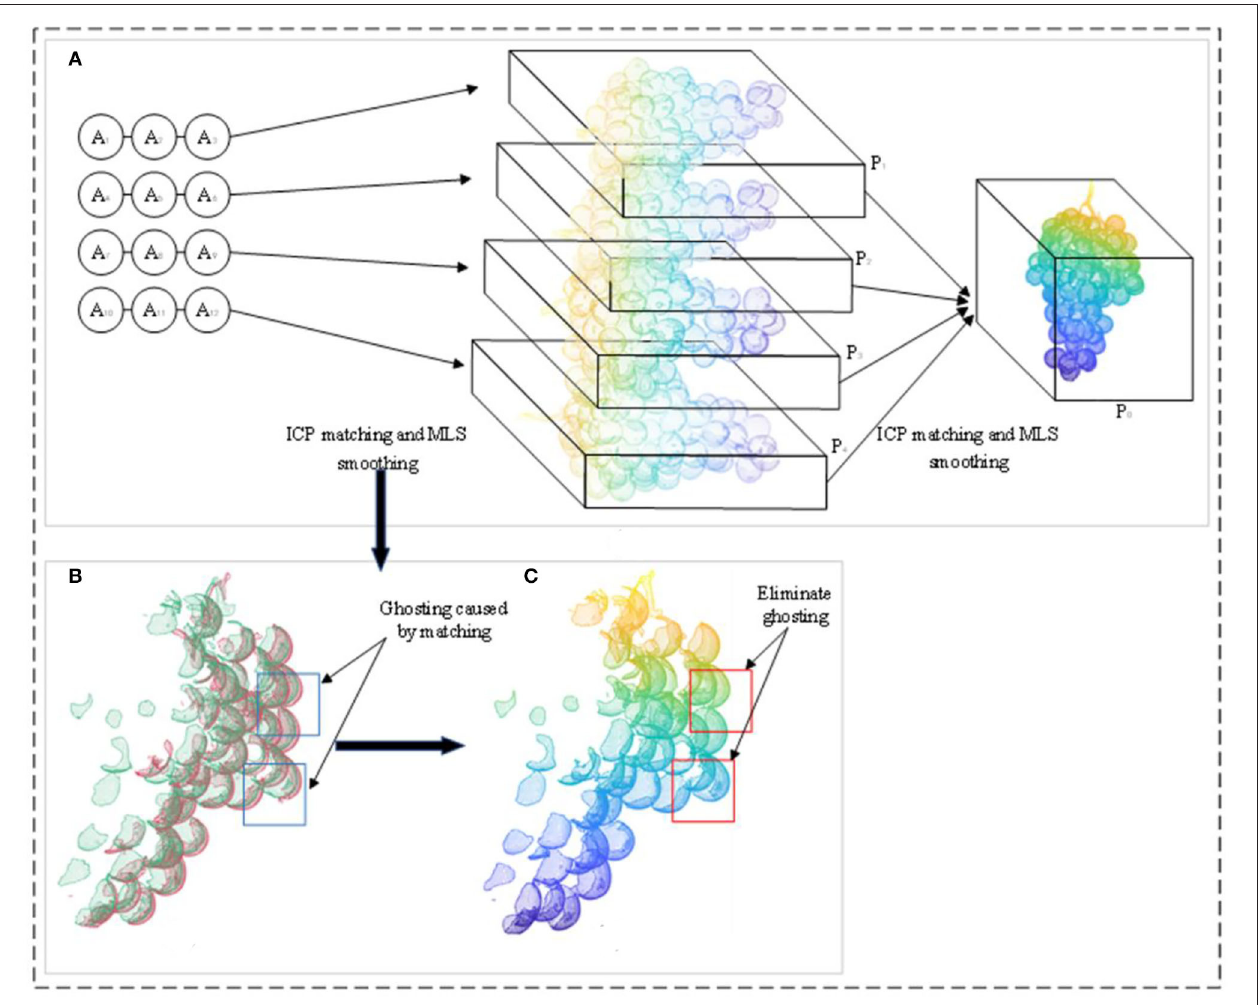
FIGURE 7 | Point cloud data processing; (A) the step of obtaining the complete grape point cloud model P0; (B) the point cloud after the registration of the point cloud data of the two angles before smoothing, which produces ghost phenomena (blue boxes); (C) is the rendered image obtained after MLS smoothing in (B) , which eliminates the ghost phenomenon (red